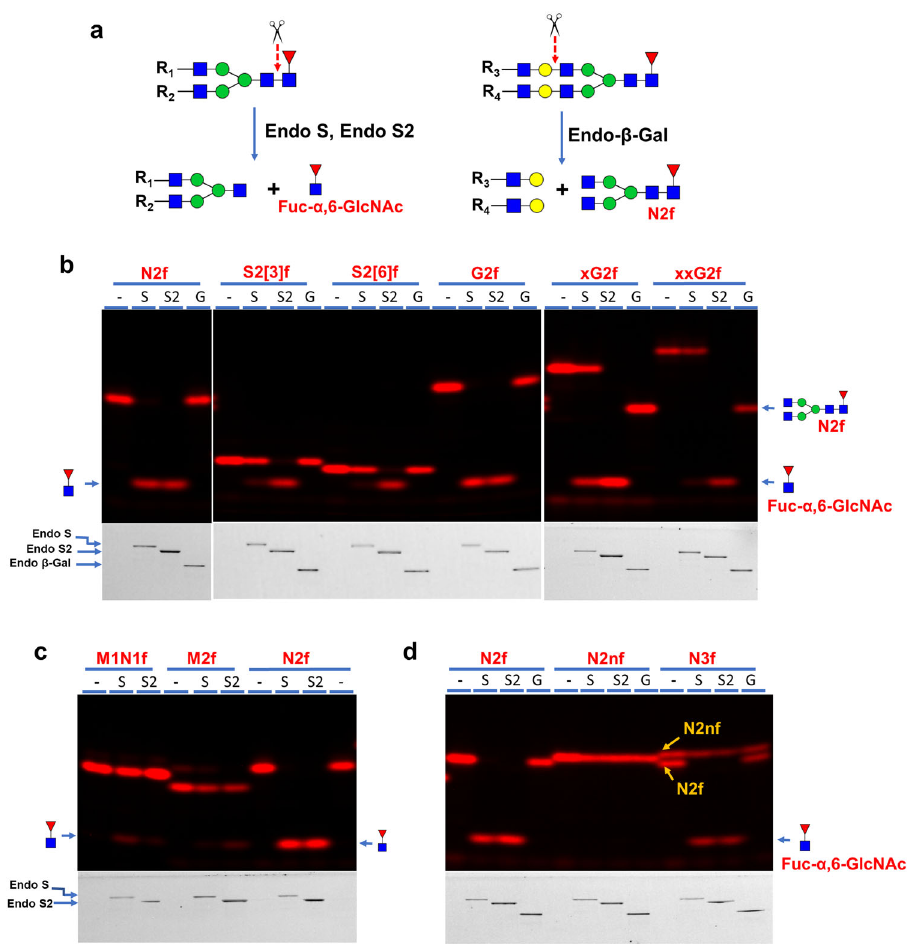
Fig. 3 Substrate speci fi city tests of Endo S (S), End S2 (S2) and Endo- β -Gal (G) on the three groups of labeled glycans. In all cases, digestions were performed at 37 °C for 20 min with 0.5 μ g of the indicated enzyme in 20 μ L buffer of 50 mM MES pH 6.0 and separated on 17% SDS-gel. Both glycan fl uorescent images and protein images of the same gels are shown. N2f was run in all three groups and served as a control. a General scheme for Endo S/S2 and Endo- β -Gal digestions. Digestion by Endo S/S2 results in the product Fuc- α ,6-GlcNAc and digestion by Endo- β -Gal results in product N2f. b Digestion of Group I glycans by all three enzymes. While Endo S2 showed complete digestion on all substrates, Endo S only showed complete digestion on N2f and G2f. Endo- β -Gal only digested xG2f and xxG2f. c Digestion of Group II glycans by Endo S/S2. Slight product formation was observed when M1N1f was digested by Endo S and M2f was digested by Endo S2. d Digestion of Group III glycans by all three enzymes. No obvious digestion was observed on these substrates. Product formation in N3f digestion by Endo S/S2 was due to the digestion on contaminated N2f that was due to incomplete conversion during